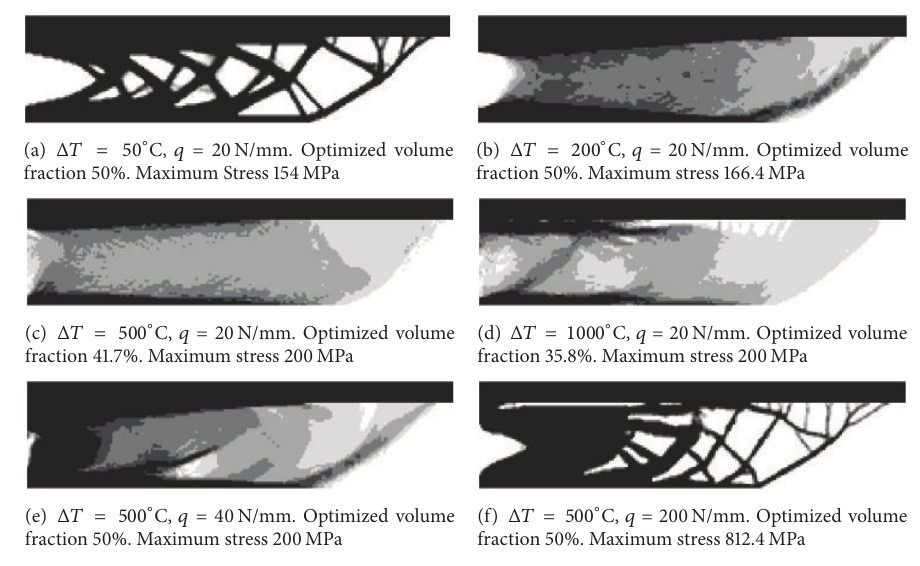
Figure 6: Optimized results of minimizing compliance under different loads.